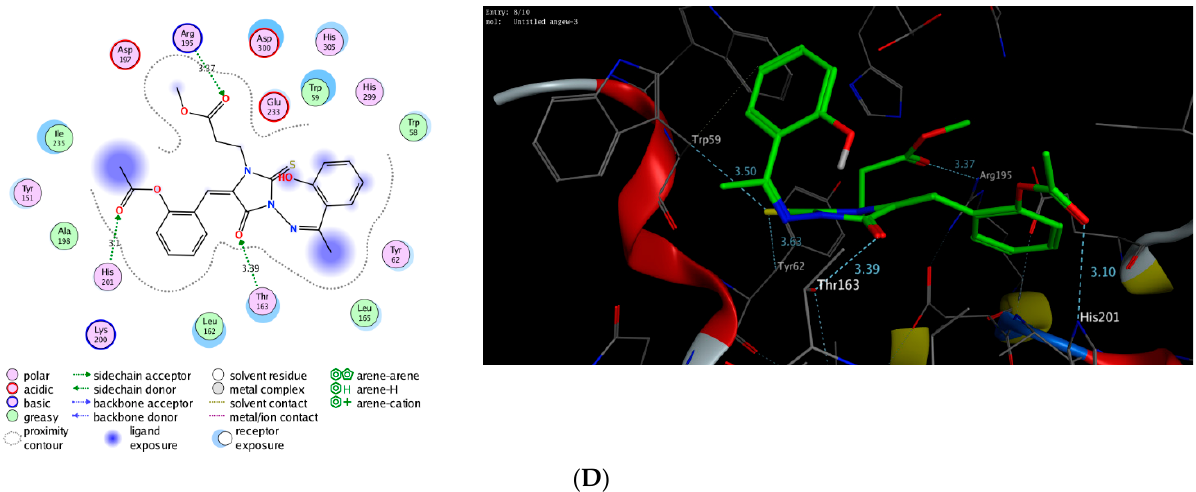
Figure 9. Interactive conformations (2D) and binding mode (3D) of compound 5a ( A , C ) and 7a ( B , D ) in the active cavity of α -glucosidase (PDB code: 3w37 ) and α -amylase (PDB code: 4gqr )